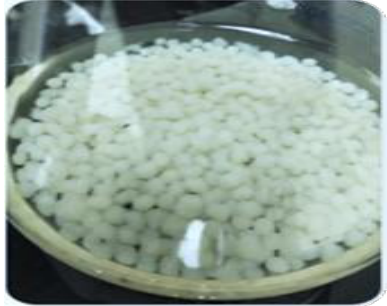
Figure 1. Immobilized S. cerevisiae.